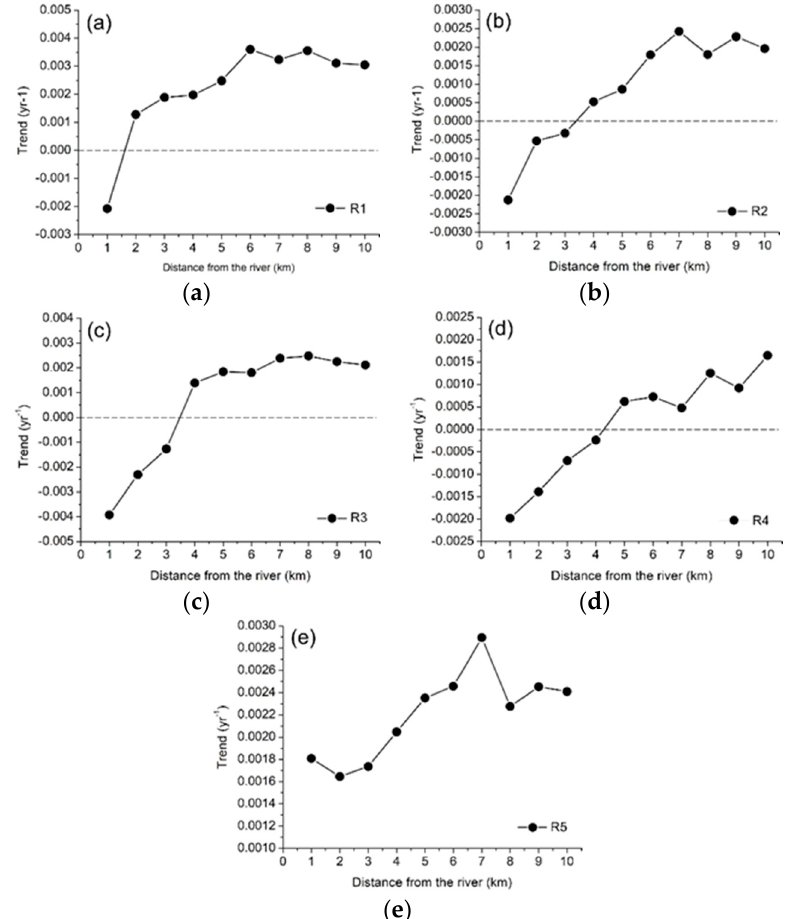
Figure 5. Comparison of the pixel-averaged change trend in NDVI within a distance of 1–10 km away from the riverway: ( a ) R1; ( b ) R2; ( c ) R3; ( d ) R4; ( e ) R5.